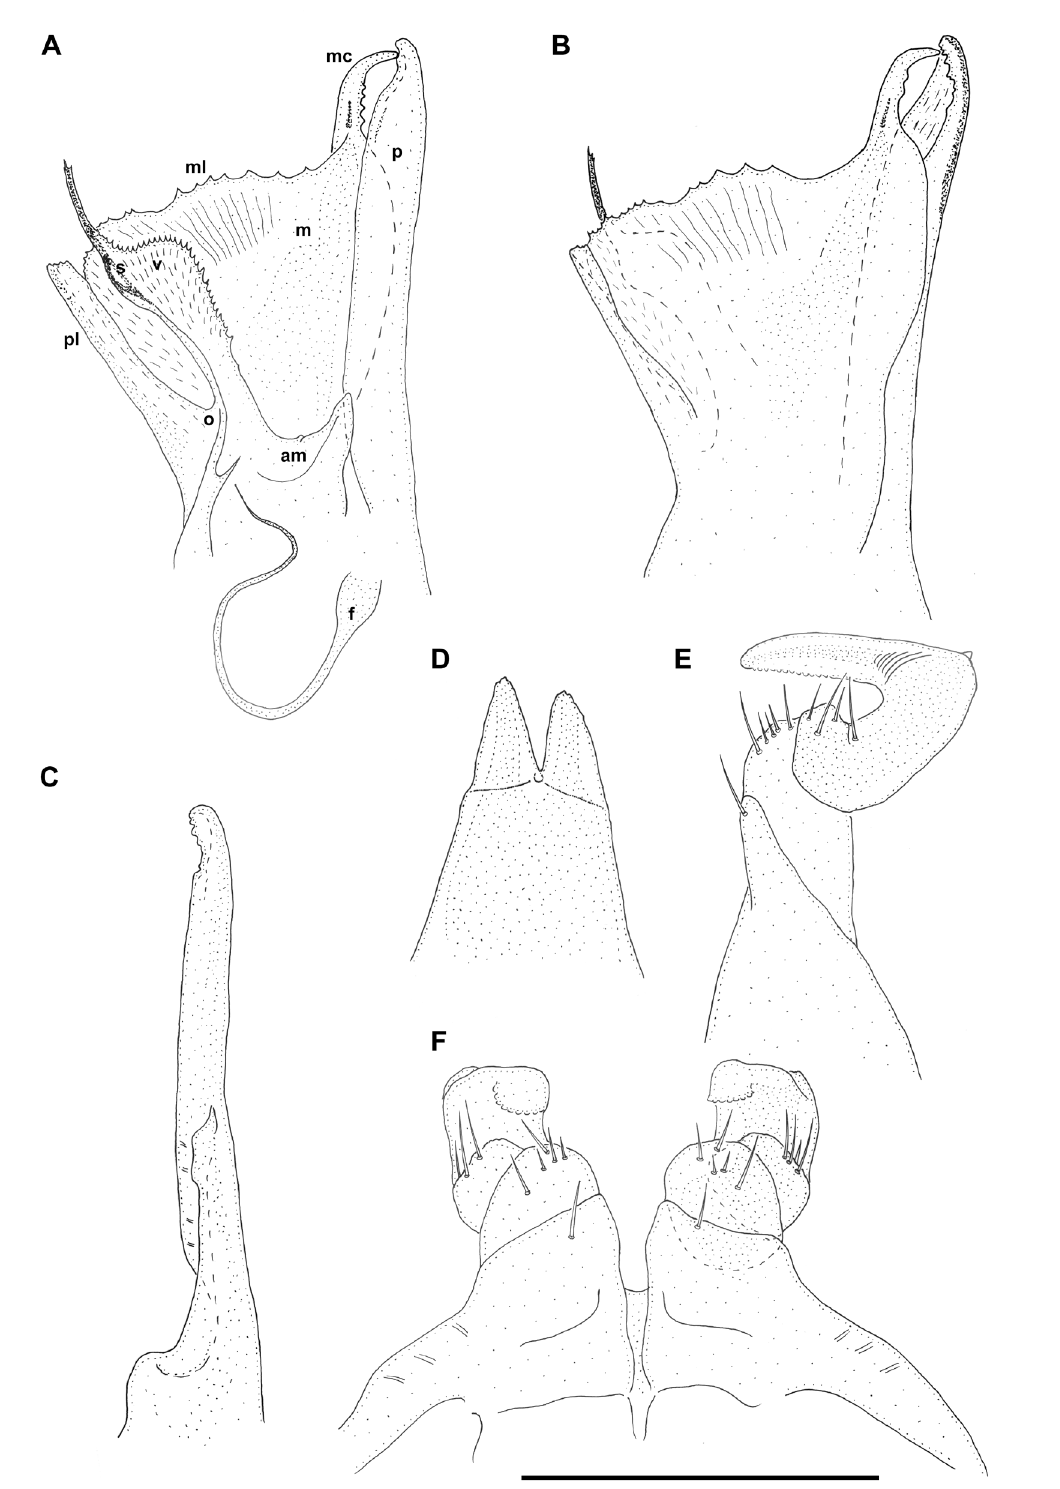
Fig. 21. Leucogeorgia gioi sp. nov., holotype ♂ from Sachinkia Cave (IZISU). A . Right gonopods, mesal view. B . Left gonopods, lateral view. C . Left promere, lateral view. D . Penes, posterior view. E . Right leg 1, lateral view. F . Leg-pair 1, anterior view. Abbreviations: am = accessory membrane; f = flagellum; m = mesomere; mc = mesomeral claw; ml = mesomeral lamella; o = opisthomere; p = promere; pl = protective lamella; s = solenomere; v = velum. Scale bar: 0.3